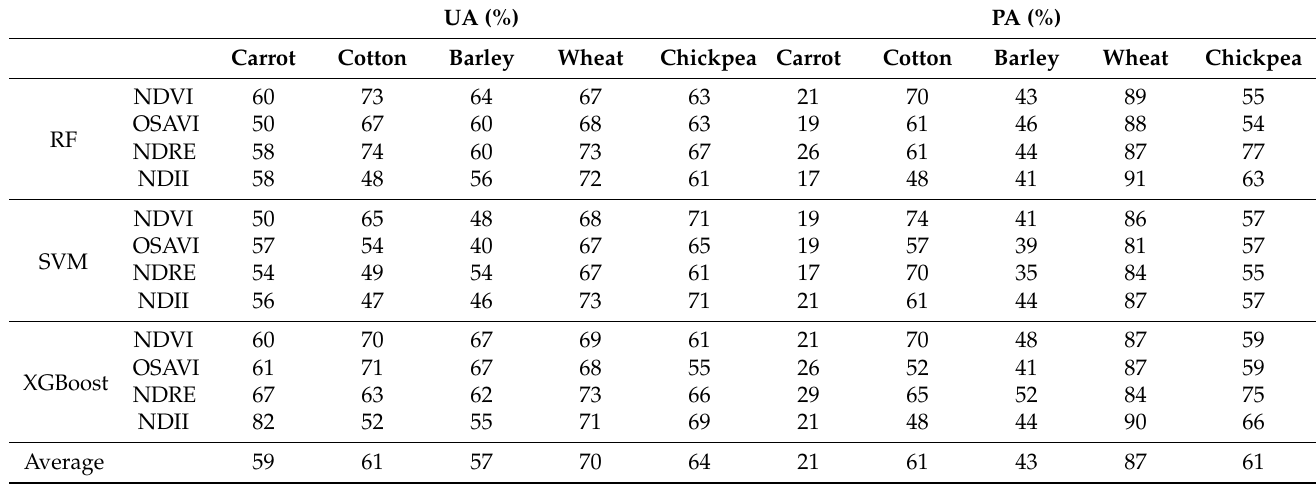
Table 3. UA and PA values of the different classification